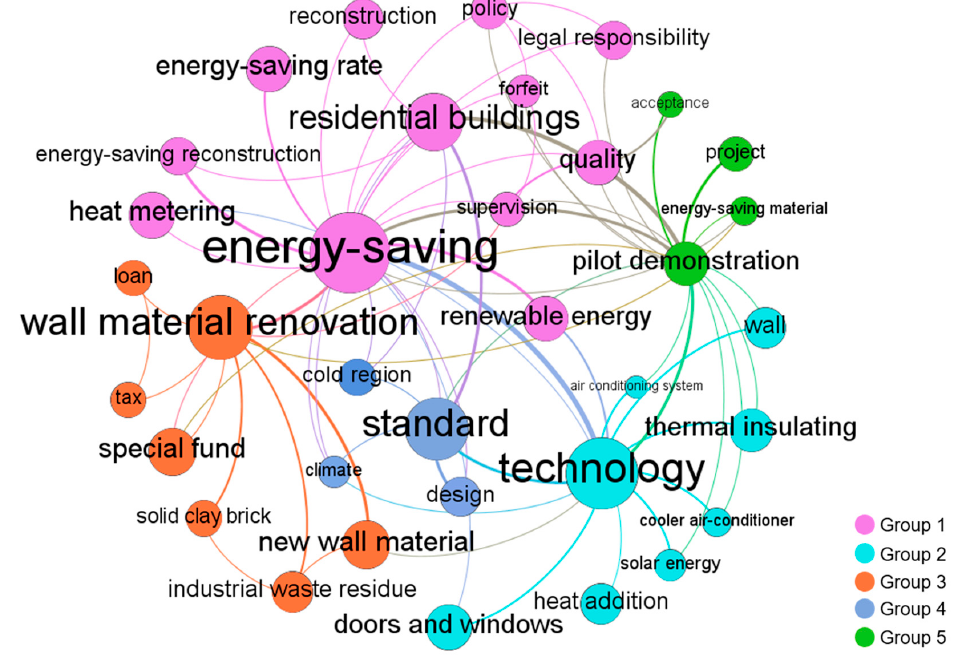
Figure 2. Co-word network of China’s GBPs in stage 1.